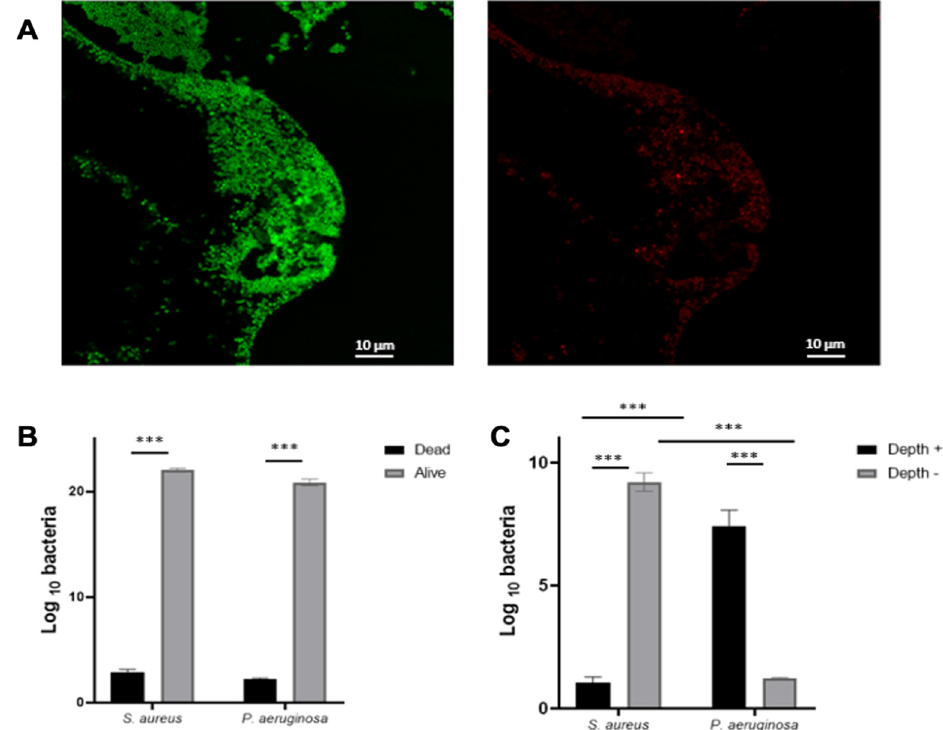
Figure 2. Spatial distribution of a mixed biofilm with S. aureus and P. aeruginosa inside the BioFlux TM 200 system. S. aureus SAC2 was cocultured 1:1 with P. aeruginosa PAC2 cells. Cells were stained with PI/Syto9 and fixed after three days of coculture and confocal microscopy was performed to show Syto9 bacteria (alive = green; ( A ), left) and PI bacteria (dead = red; A, right) and stained bacteria were quantified ( B ). Images taken from the deepest part of the biofilm and the surface of the P. aeruginosa / S. aureus biofilm were quantified ( C ). Results are presented as the mean ± standard deviation of three different experiments. Statistics were performed using a t -test on GraphPad Prism version 9.2. *** p < 0.001.